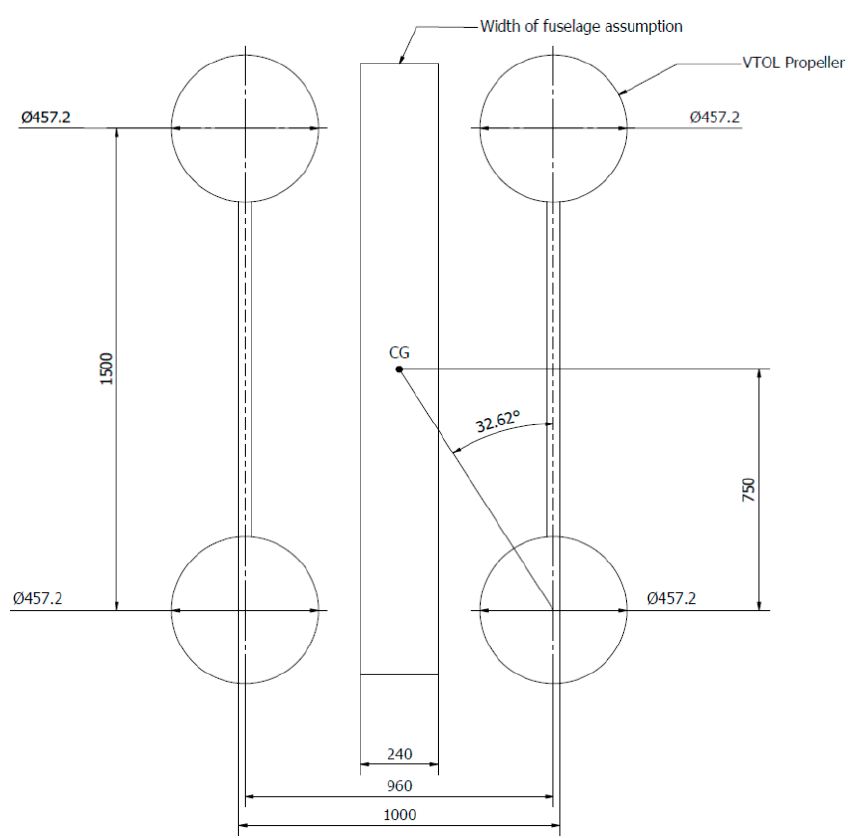
Figure 4. Position of the VTOL motors.